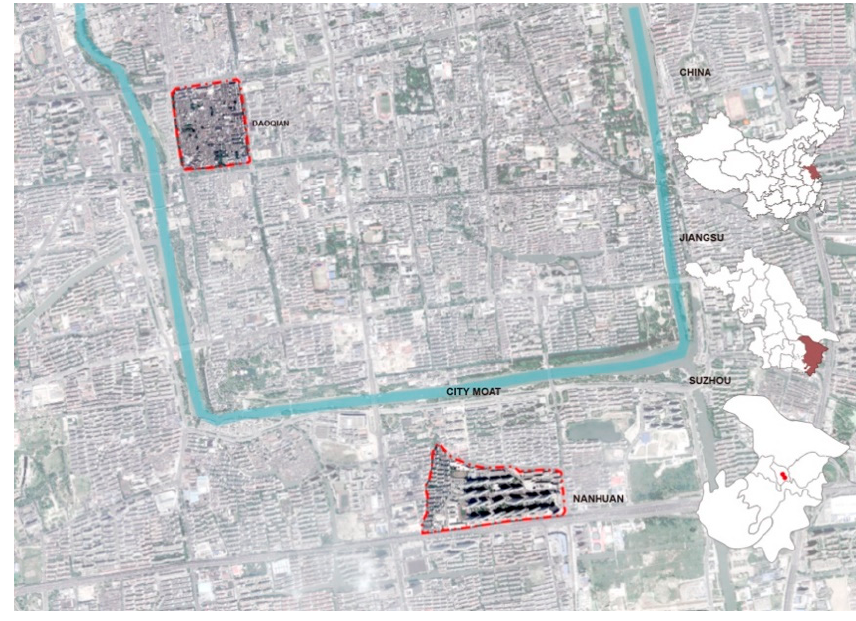
Figure 3. Locations of Nanhuan and Daoqian.